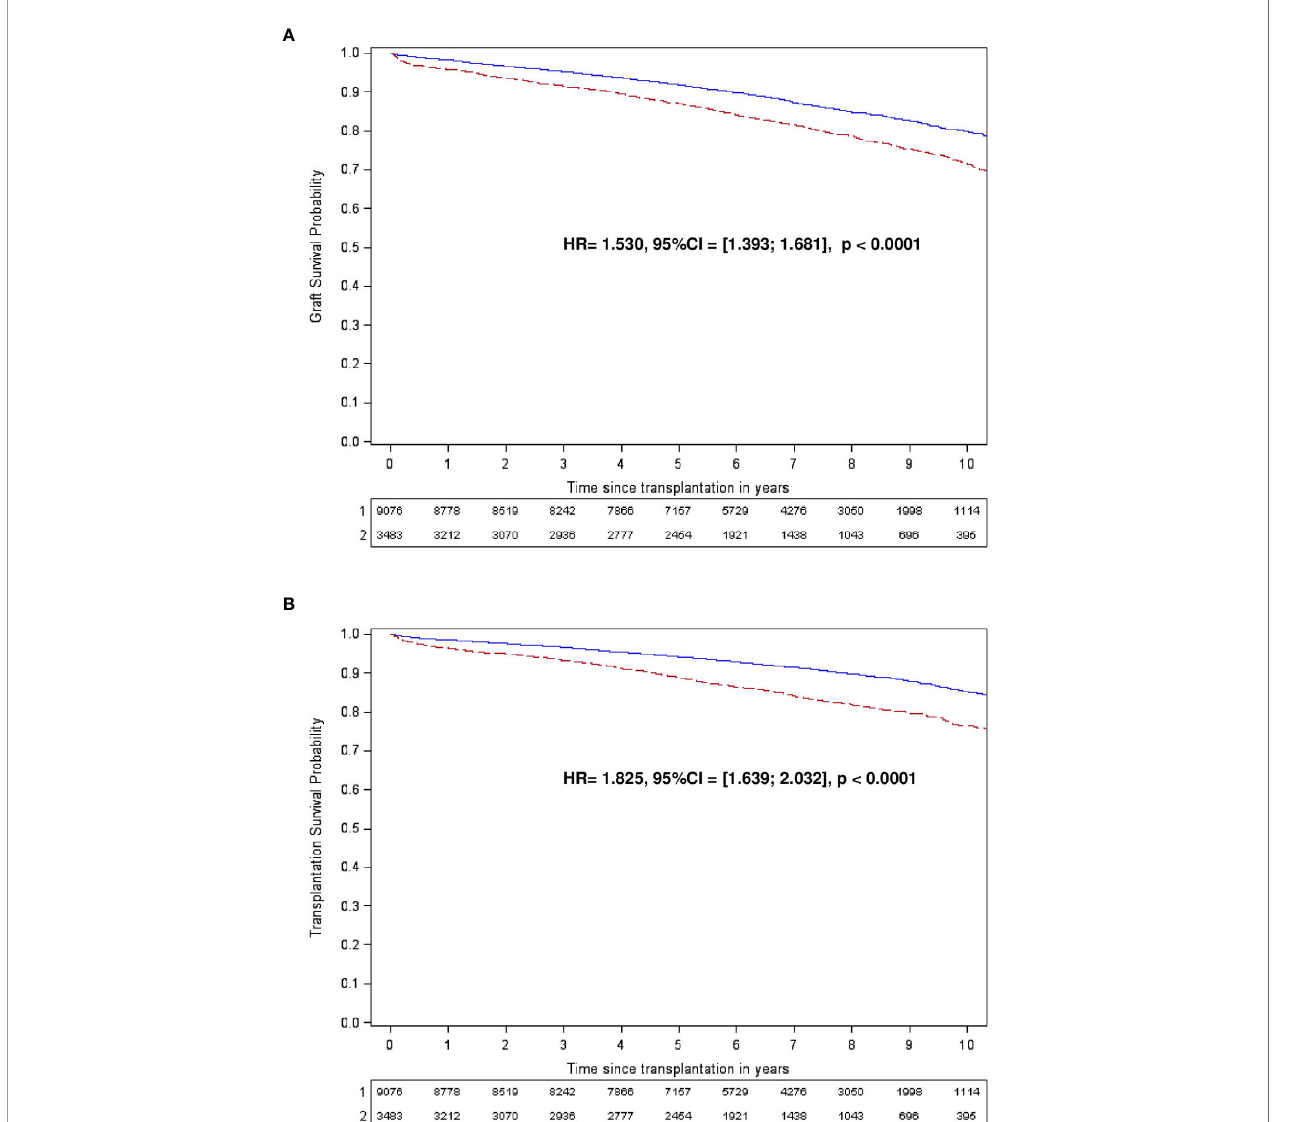
FIGURE 3 | Kaplan-Meier graft (A) and transplantation (B) survival curves according to the post-transplantation transfusion. (A, B) Patients transfused (in red) or not (in blue) are followed for 10 years. TX,